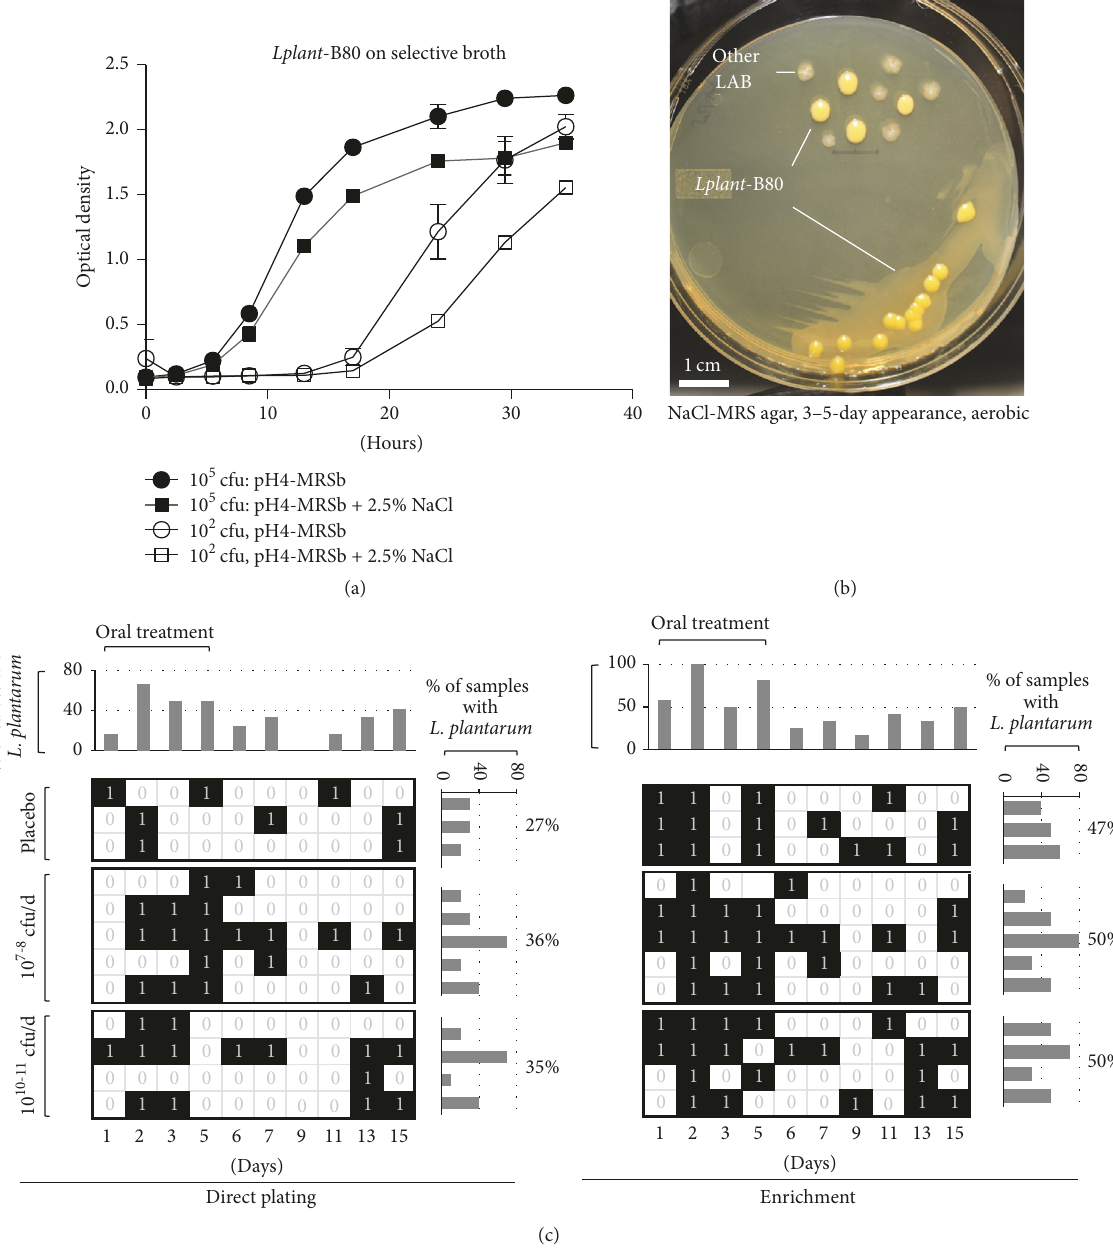
Figure 2: Selective microbial enumeration and colonization of L. plantarum Lplant -B80 following oral administration of low- and high doses in neonatal calves. (a) The use of optical density for quantification of bacterial growth in broth allowed the identification of optimal acid and salt concentrations to favor the optimal growth of as few as 10 2 CFU of Lplant -B80 in an acid/salt-MRS broth, under aerobic conditions, preventing the growth of most previously tested LAB in our laboratory; see [9]. (b) Large distinct colonies for Lplant -B80 on MRS-salt agar, from a fraction of freeze-dried pellet stored for 48 months at room temperature and rehydrated with PBS. (c) Binary analysis of fecal colonization with L. plantarum Lplant -B80 before, during, and after administration. 1, recovered; 0, not recovered. Note similar overall recovery rate (histograms) across groups and high recovery during treatment